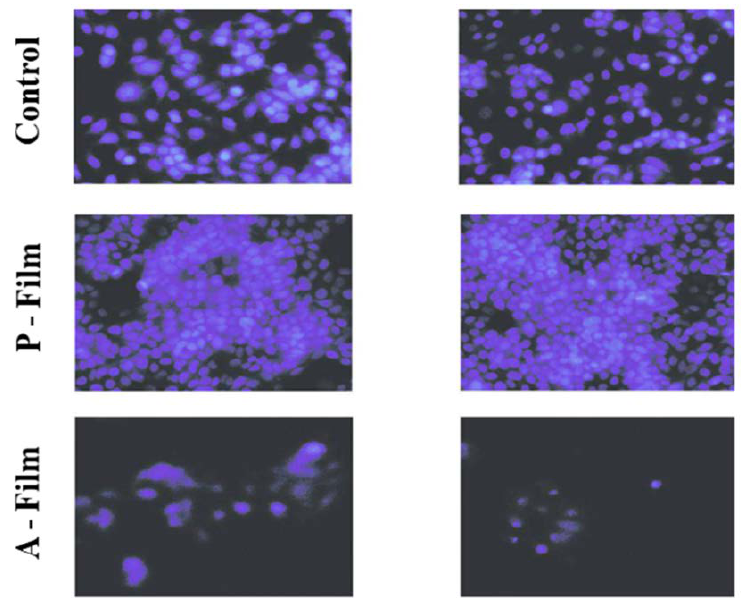
Figure 11. Effect of A-film and P-film on MCF 7 cell viability after 72 h of incubation. The cells density observed by UV-light is higher for P-film, and it is lower for A-film. The blue color of the nucleus treated with 4′, 6 -di-diamidino-2-phenylindole (DAPI, 300 nM) was observed and photographed through the Nikon TS-100 fluorescence microscope with the attached DXM1200F digital camera. Magnification 10×.